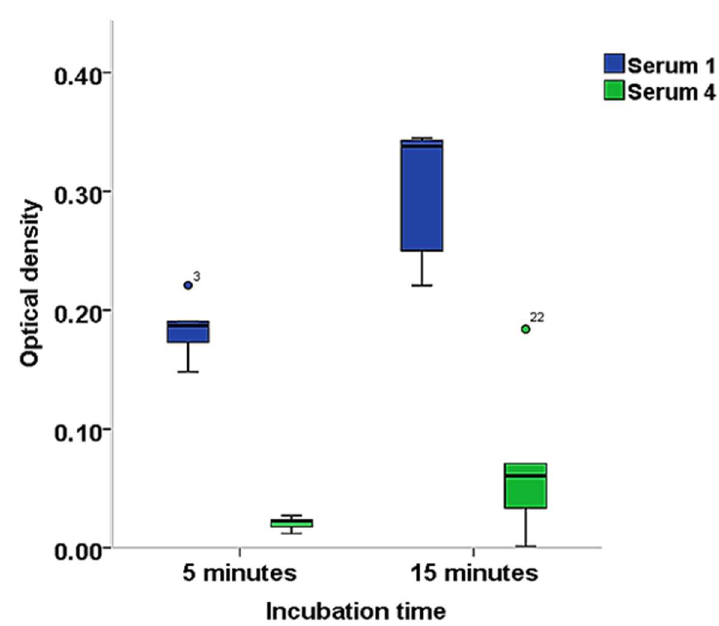
Figure 4. Distribution of optical densities comparing 5- and 15-min substrate incubation times for HCoV-NL63 rIFA-positive (Serum 1) and negative (Serum 4) sera. Colored dots indicate outliers.